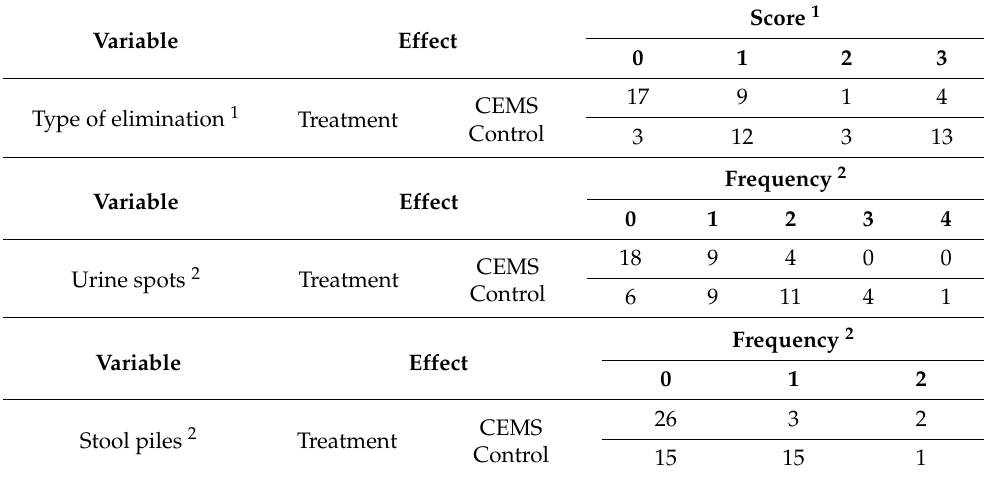
Table 3. Score of type of elimination, frequencies of urine spots and stool piles according to treatment. Variable